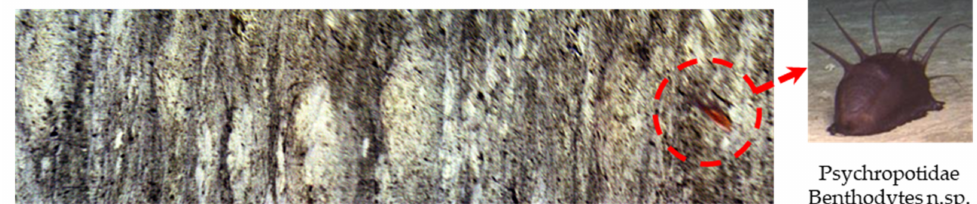
Figure 15. The pseudo-RGB (R: 640 nm, G: 550 nm, B: 470 nm) image of the seafloor in the northwest Indian ocean. A captured Psychropotidae specimen is shown on the